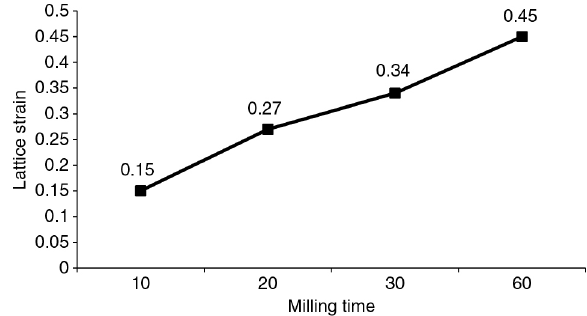
Figure 4: Lattice strain of mixture powders as a function of milling time.